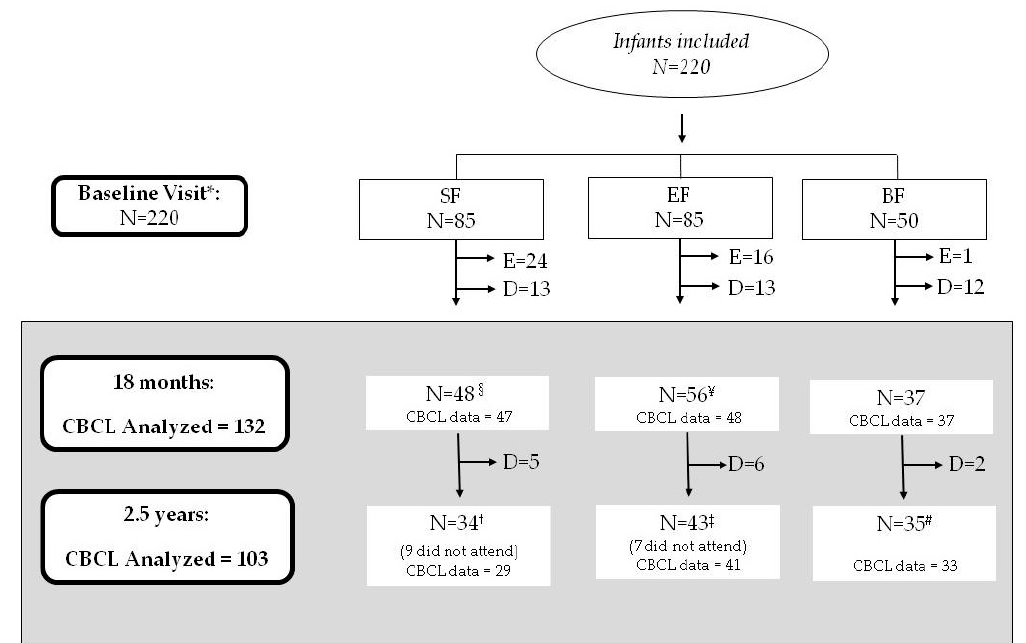
Figure 1. Participant flowchart from recruitment to 2.5 years old. SF, standard infant formula; EF, experimental infant formula; BF, breastfed infants; D, drop-outs; E, exclusions, N, sample size. Up to 18 months of life, a total of 40 infants were excluded in the SF and EF groups as follows: 24 were excluded in the SF group (1 infant due to perinatal hypoxia, 1 infant had growth deficiency, 15 infants met the withdrawal criteria referring to formula intake, 2 infants were colic, 3 were excluded due to lactose intolerance, 1 infant was due to digestive surgical intervention, and 1 infant suffered hydrocephalus); 16 infants were excluded in the EF group (2 infants presented growth deficiency, 2 infants lactose intolerance, 11 infants met the withdrawal criteria referring to formula intake, and 1 was excluded due to epileptic seizure). Furthermore, one infant of the BF group was excluded because they were not breastfed. * BF infants were randomized between 0–6 months of age. § 1 mother did not fill the child behavior checklist (CBCL) test at 18 months old; ¥ 8 mothers did not complete the CBCL test at 18 months old; † 5 mothers did not fill the CBCL test at 2.5 years old; ‡ 2 mothers did not fill the CBCL test at 2.5 years old; # 2 mothers did not complete the CBCL test at 2.5 years old. Sixteen children at 2.5 years old did not show up at the evaluation (described as “did not attend”). During the